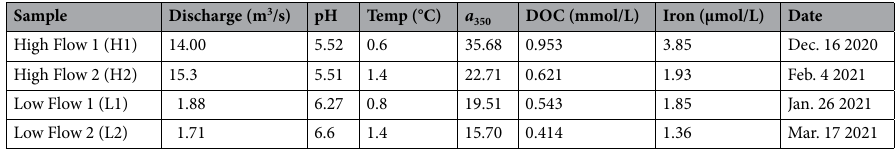
Table 1. Sample characteristics at the time of sampling.